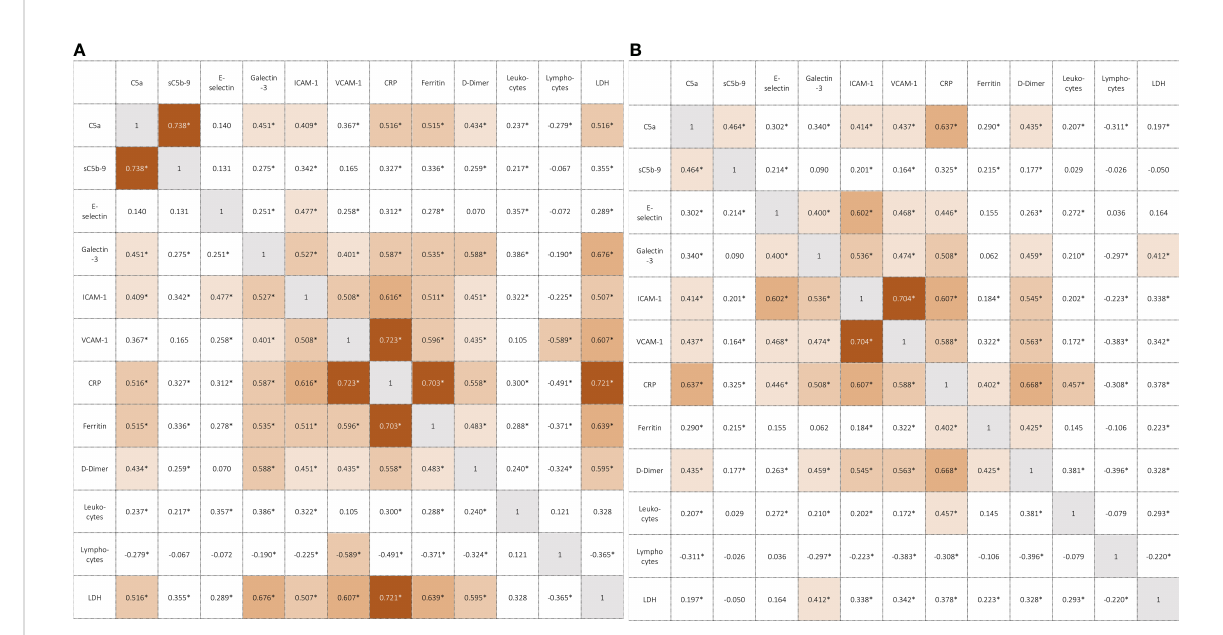
FIGURE 1 (A) Correlation coef fi cients in COVID-19 patients. *p<0.01 (Spearman correlation coef fi cient), CRP, C-reactive protein; LDH, lactate dehydrogenase. (B) Correlation coef fi cients in controls. *p<0.01 (Spearman correlation coef fi cient), CRP, C-reactive protein; LDH, lactate dehydrogenase.